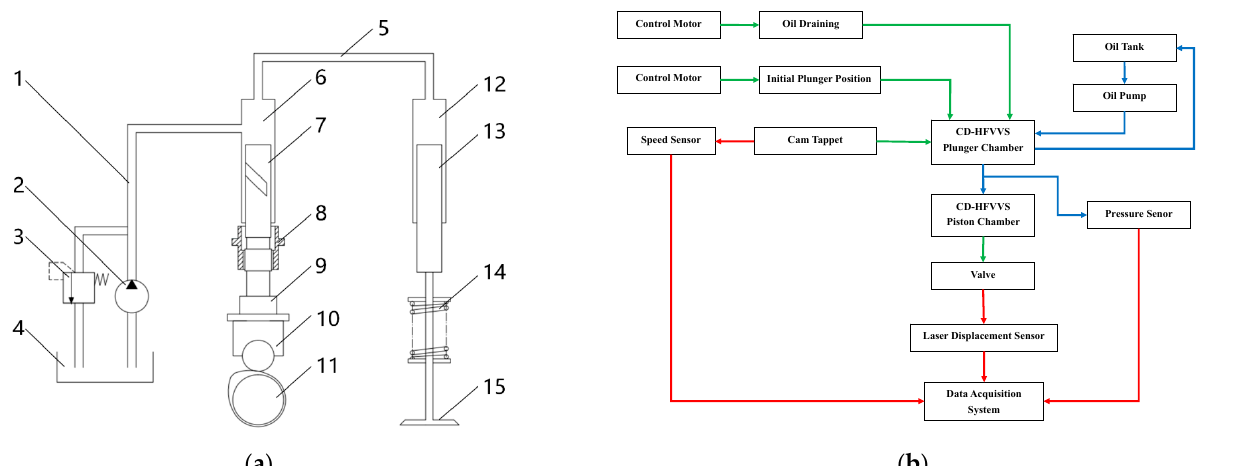
Figure 1. Schematic diagram of valve mechanism experiment, including ( a ) CD ‐ HFVS mechanism sketch: 1. Low Pressure Oil Ducts, 2. Low Pressure Oil Pump, 3. Relief Valve, 4. Hydraulic Tank, 5. High Pressure Oil Ducts, 6. Plunger Chamber, 7. Plunger, 8. Plunger Rotary Sleeve, 9. Plunger Seat, 10. Tappet, 11. Camshaft, 12. Piston Chamber, 13. Piston, 14. Valve Spring, and 15. Valve; and ( b ) experimental schematic diagram.